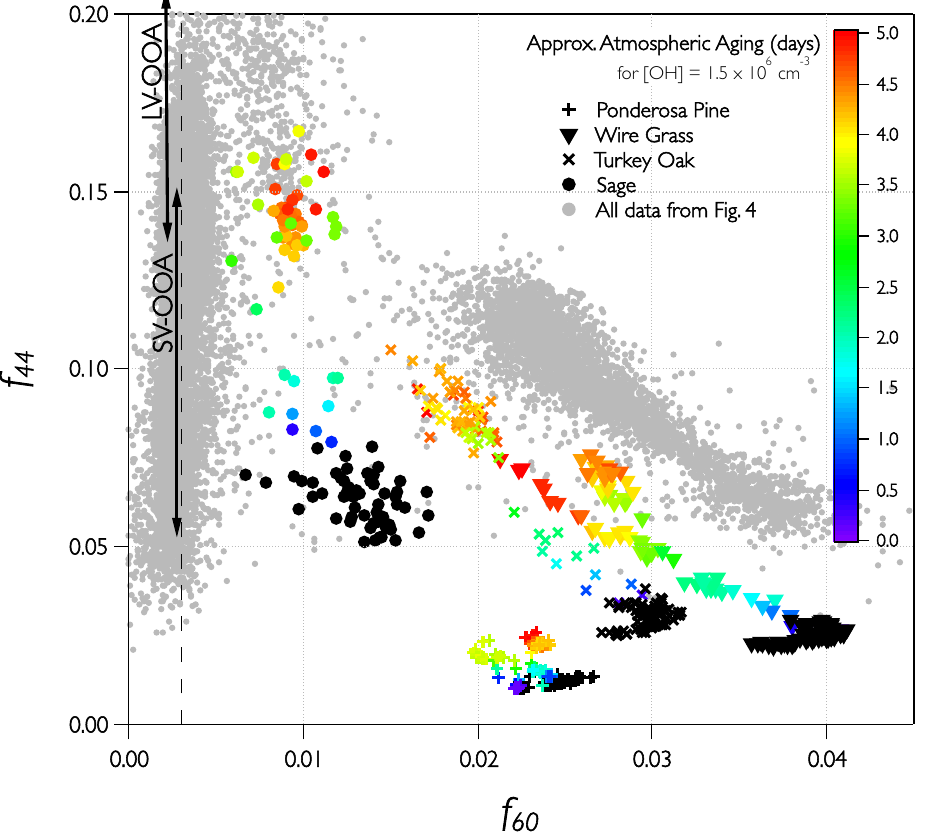
Fig. 5. f 44 vs. f 60 ratios for laboratory smoke during FLAME-3, and after processing with the Potential Aerosol Mass (PAM) flowtube. The colour scale indicates the estimated processing time of the aerosol in the flowtube, after normalisation to the stated 1.5 × 10 6 atmospheric [OH] level. The background f 60 level of 0.3% of OA is indicated by the dashed line in the figure and the data from the negligible-BB campaigns SOAR-1, BEARPEX and CalNex are also shown. The typical oxidation range exhibited by ambient SV-OOA and LV-OOA is indicated with the vertical